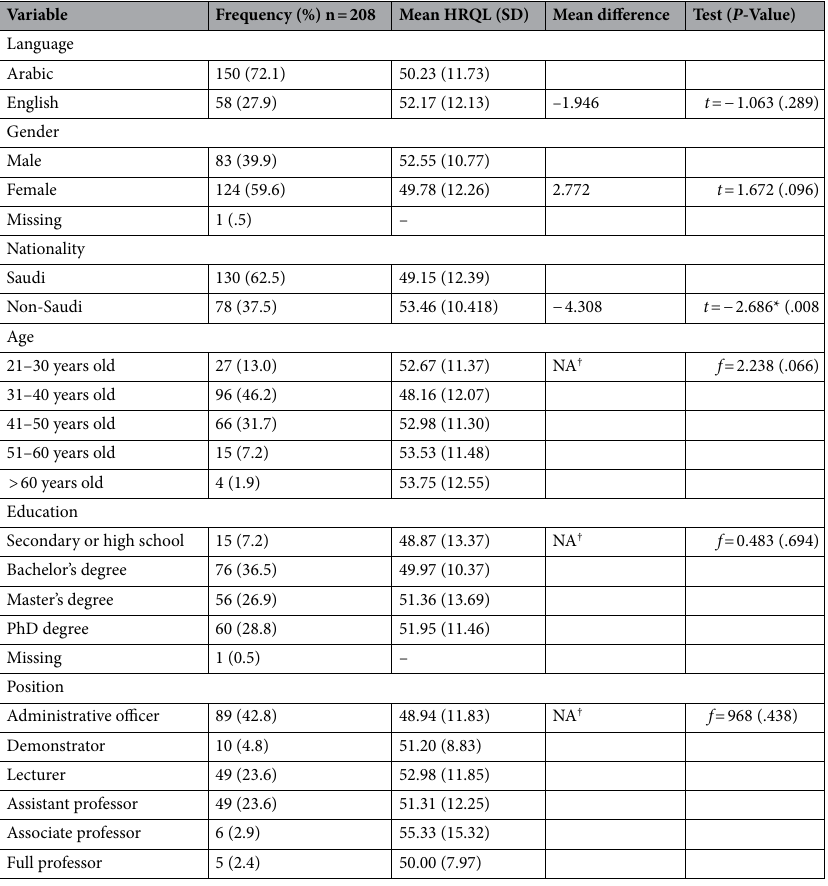
Table 1. Mean HRQL Score Across Study Participants. * p < 0.05. † NA: the variable has more than 2 groups, thus measuring the mean difference is not applicable. HRQL Health-related quality of